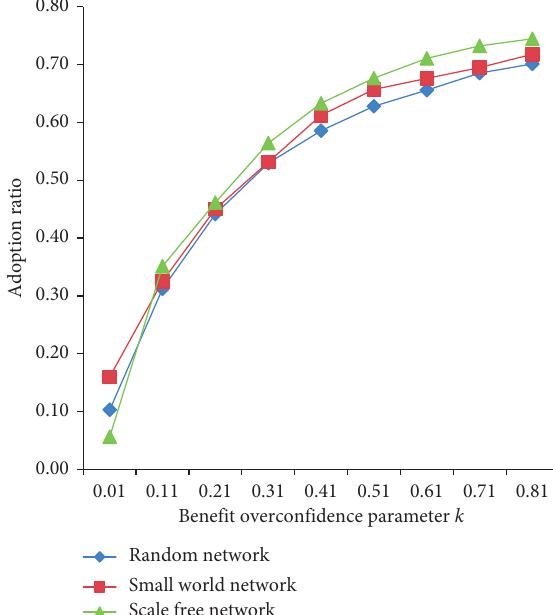
Figure 17: Effect of benefit overconfidence on product diffusion under different networks.